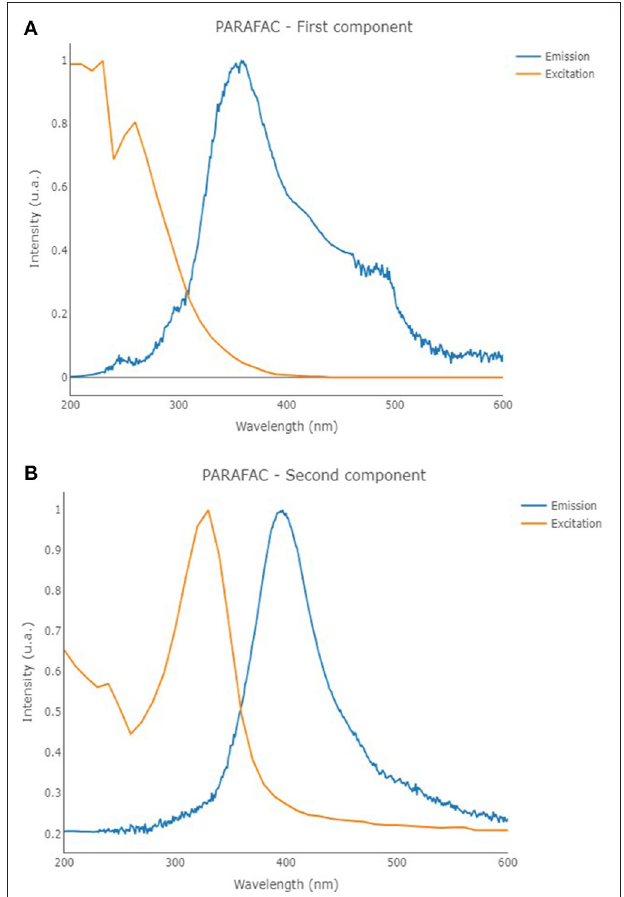
FIGURE 5 | Excitation (orange line) and emission (blue line) profiles of the first (A) and second (B) components of the PARAFAC model that was built on the solutions containing only TA.